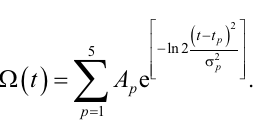
t G functions with the Φ( )/